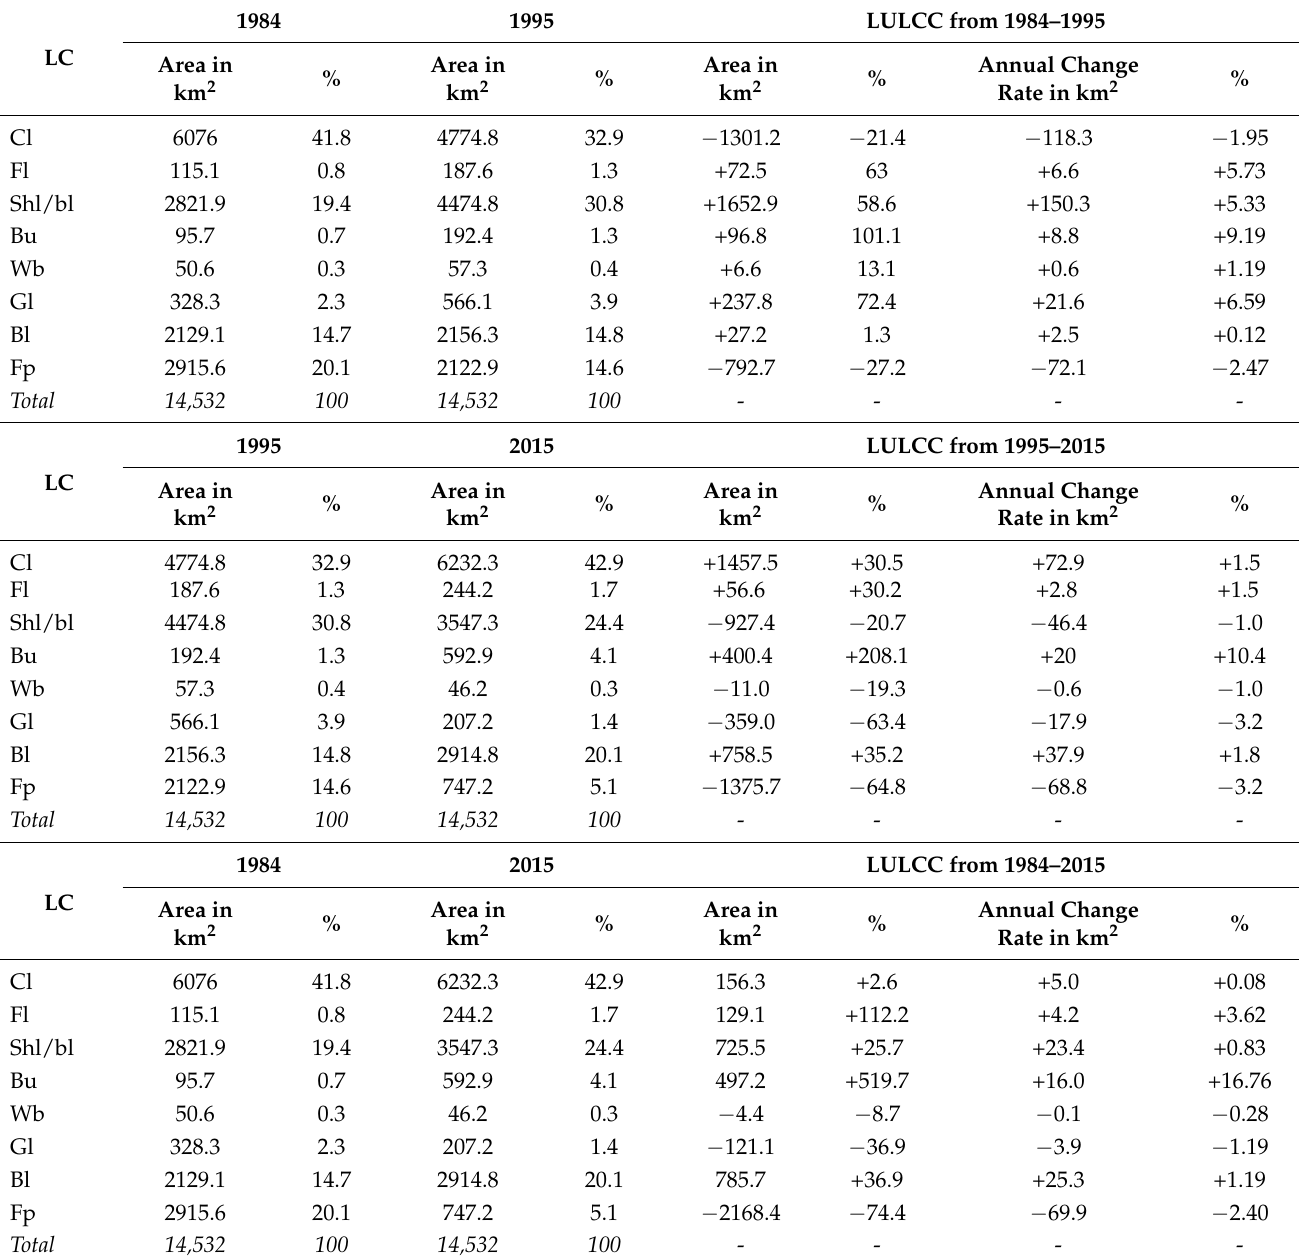
Table 4. Land use and land cover change of the study area